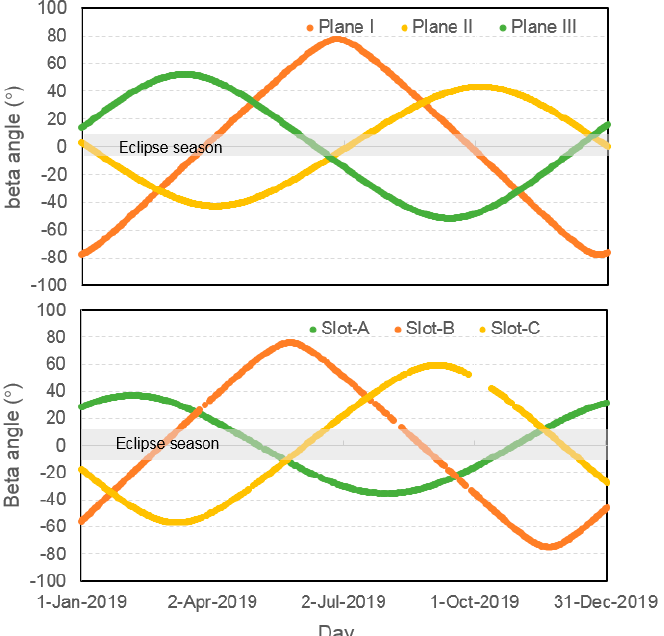
Figure 1. Elevation of the Sun ( β angle) with respect to the BeiDou navigation satellite system (BDS) orbital planes for inclined geostationary orbit (IGSO) ( up ) and medium earth orbit (MEO) ( bottom ) satellites from day of year (DOY) 1 to 365, 2019. The shaded area indicates the eclipse seasons.